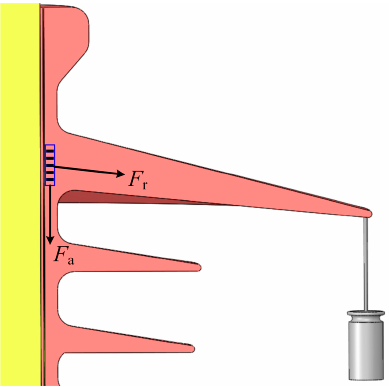
Figure 8. Force analysis on FBG during the simulated glaze icing load experiment.